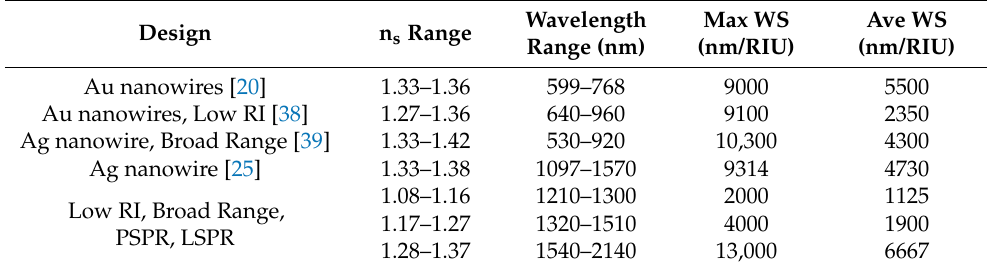
Table 2. Performance analysis of the same type of sensors.